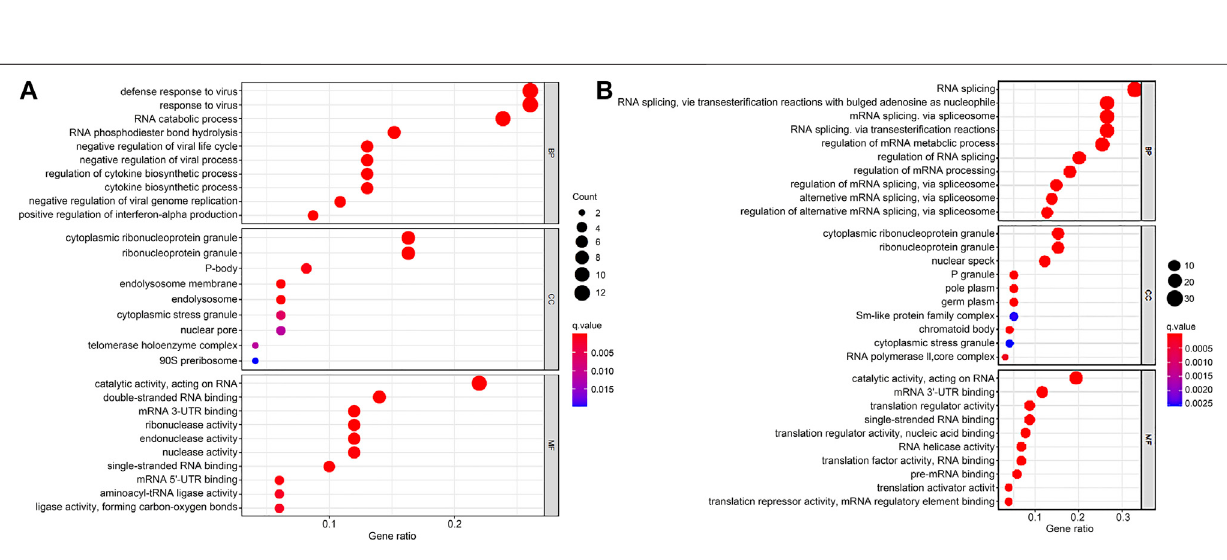
FIGURE 2 | GO enrichment analysis of DERBPs based on BP, CC, and MF biological processes. (A) GO enrichment analysis of upregulated RBPs. (B) GO enrichment analysis of downregulated RBPs. The y -axis shows a signi fi cantly enriched project ( p < 0.05, FDR < 0.05). GO, Gene Ontology; DERBPs, differentially expressed RBPs; BP, biological process; CC, cellular component; MF, molecular